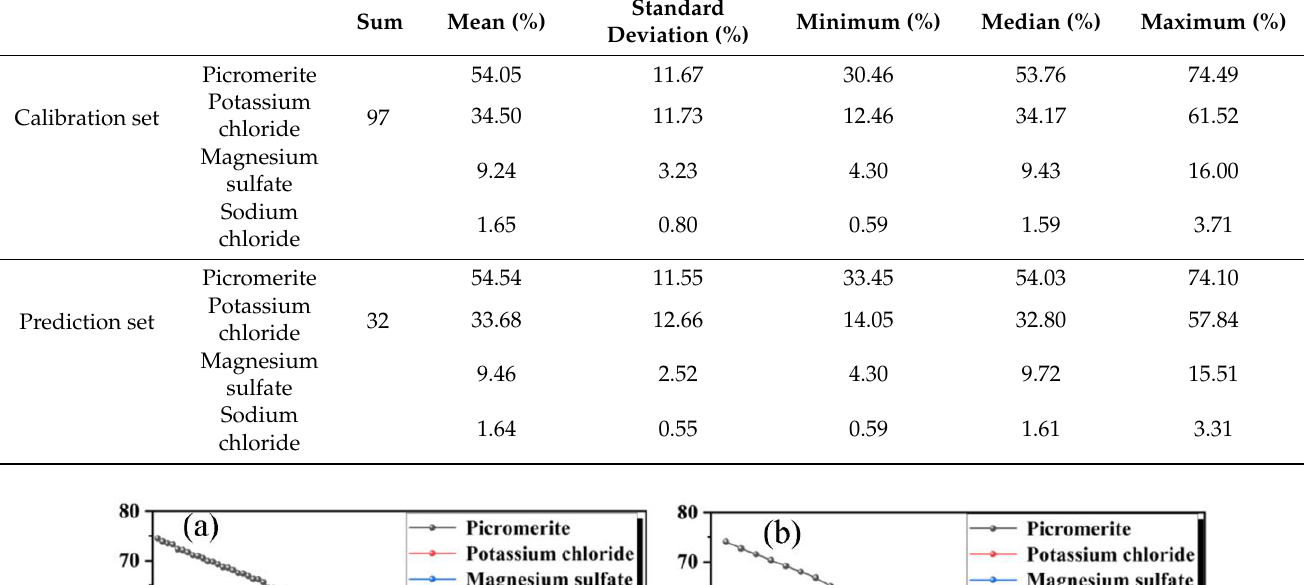
Table 4. Mineral composition statistics from the calibration set (104 MP samples) and the prediction set (34 MP samples): mean, standard deviation, minimum, median, and maximum.